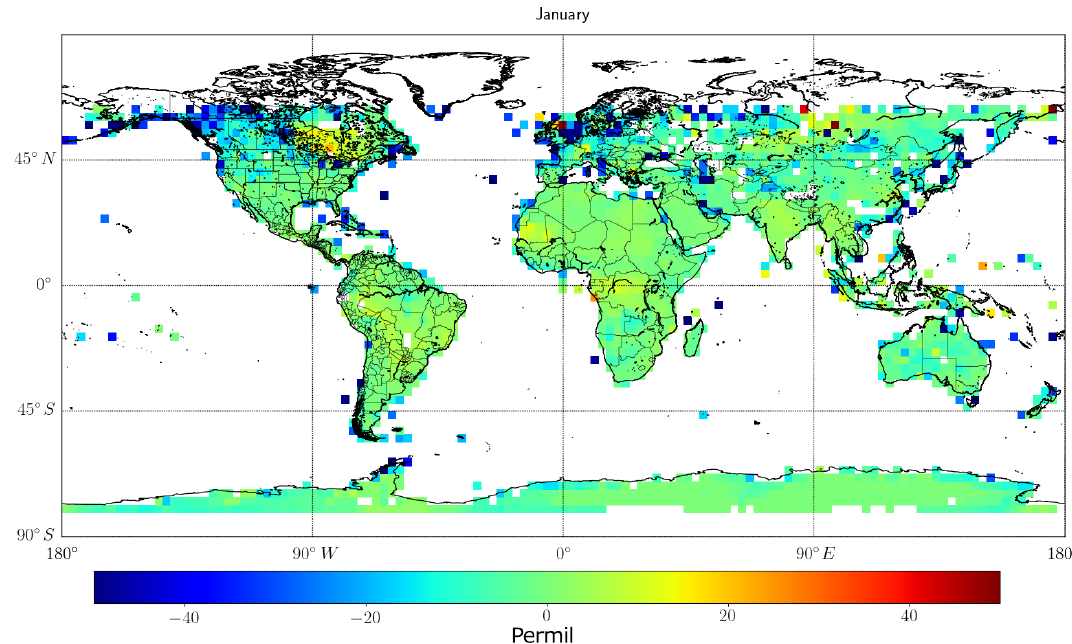
Figure 17. As Fig. 16 but focused on the common SWIR3